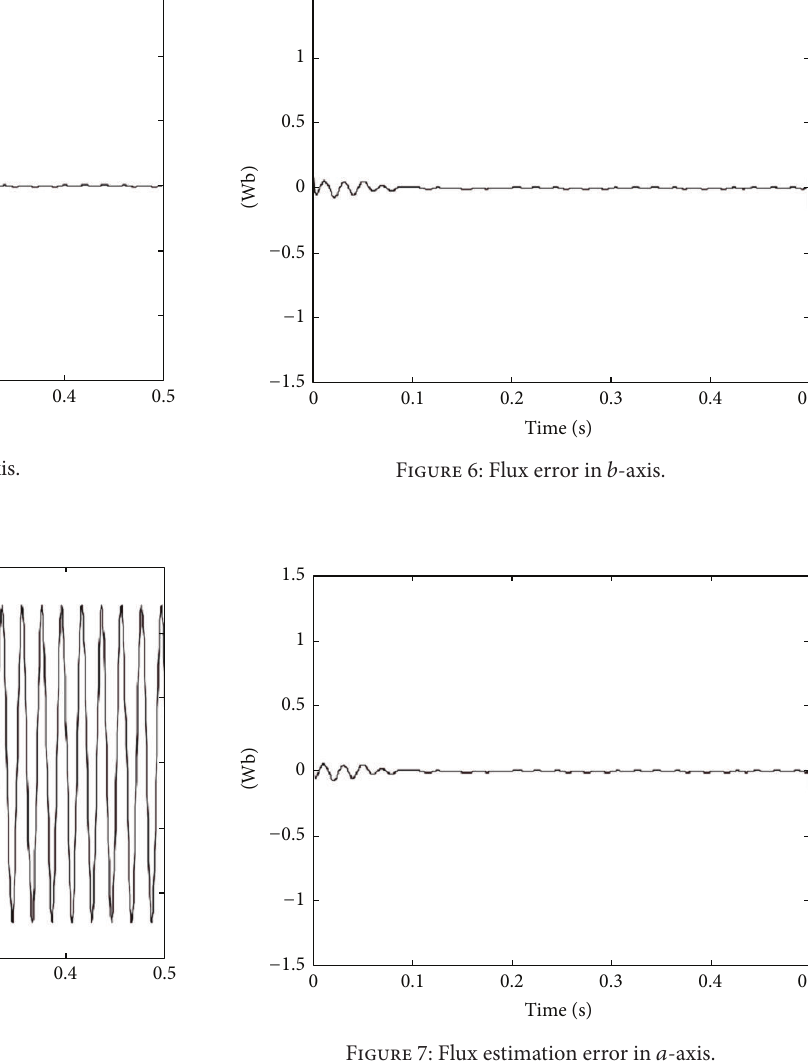
Figure 7: Flux estimation error in 𝑎 -axis.